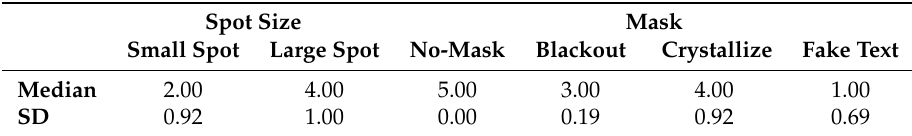
Table 1. When asked if “Reading with . . . was confusing” on a 5-point Likert scale (1 = strongly agree; 5 = strongly disagree), participants indicated that the crystallized mask was the least confusing, while fake text was the most confusing. Participants also preferred a larger spot over a smaller